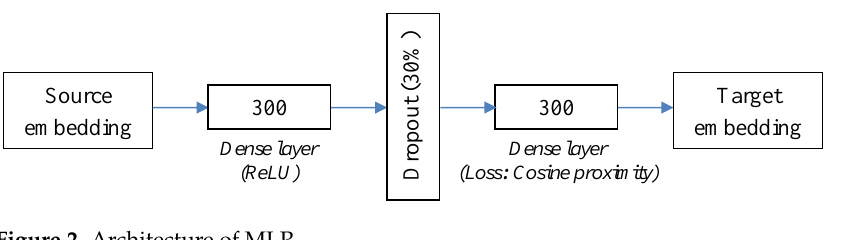
Figure 2. Architecture of MLP.